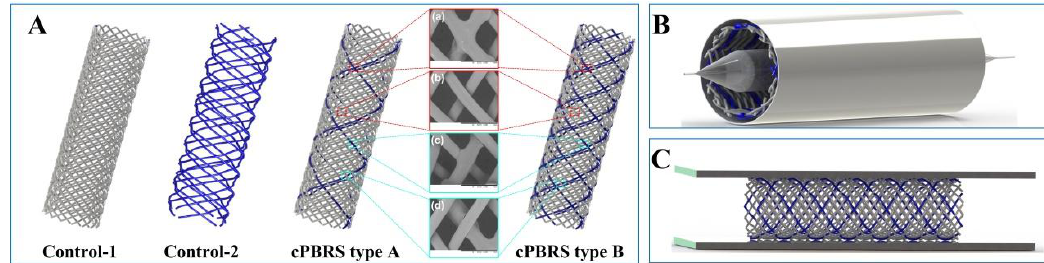
Figure 1. Schematic diagram of PBRSs crimping and expanding measurement. ( A ) Schematic diagram and morphology of different prototypes; ( B ) Crimping and balloon-expanding measurement; ( C ) Parallel plate measurement. (Grey yarns represent PPDO monofilaments, dark blue yarns represent cMYs).